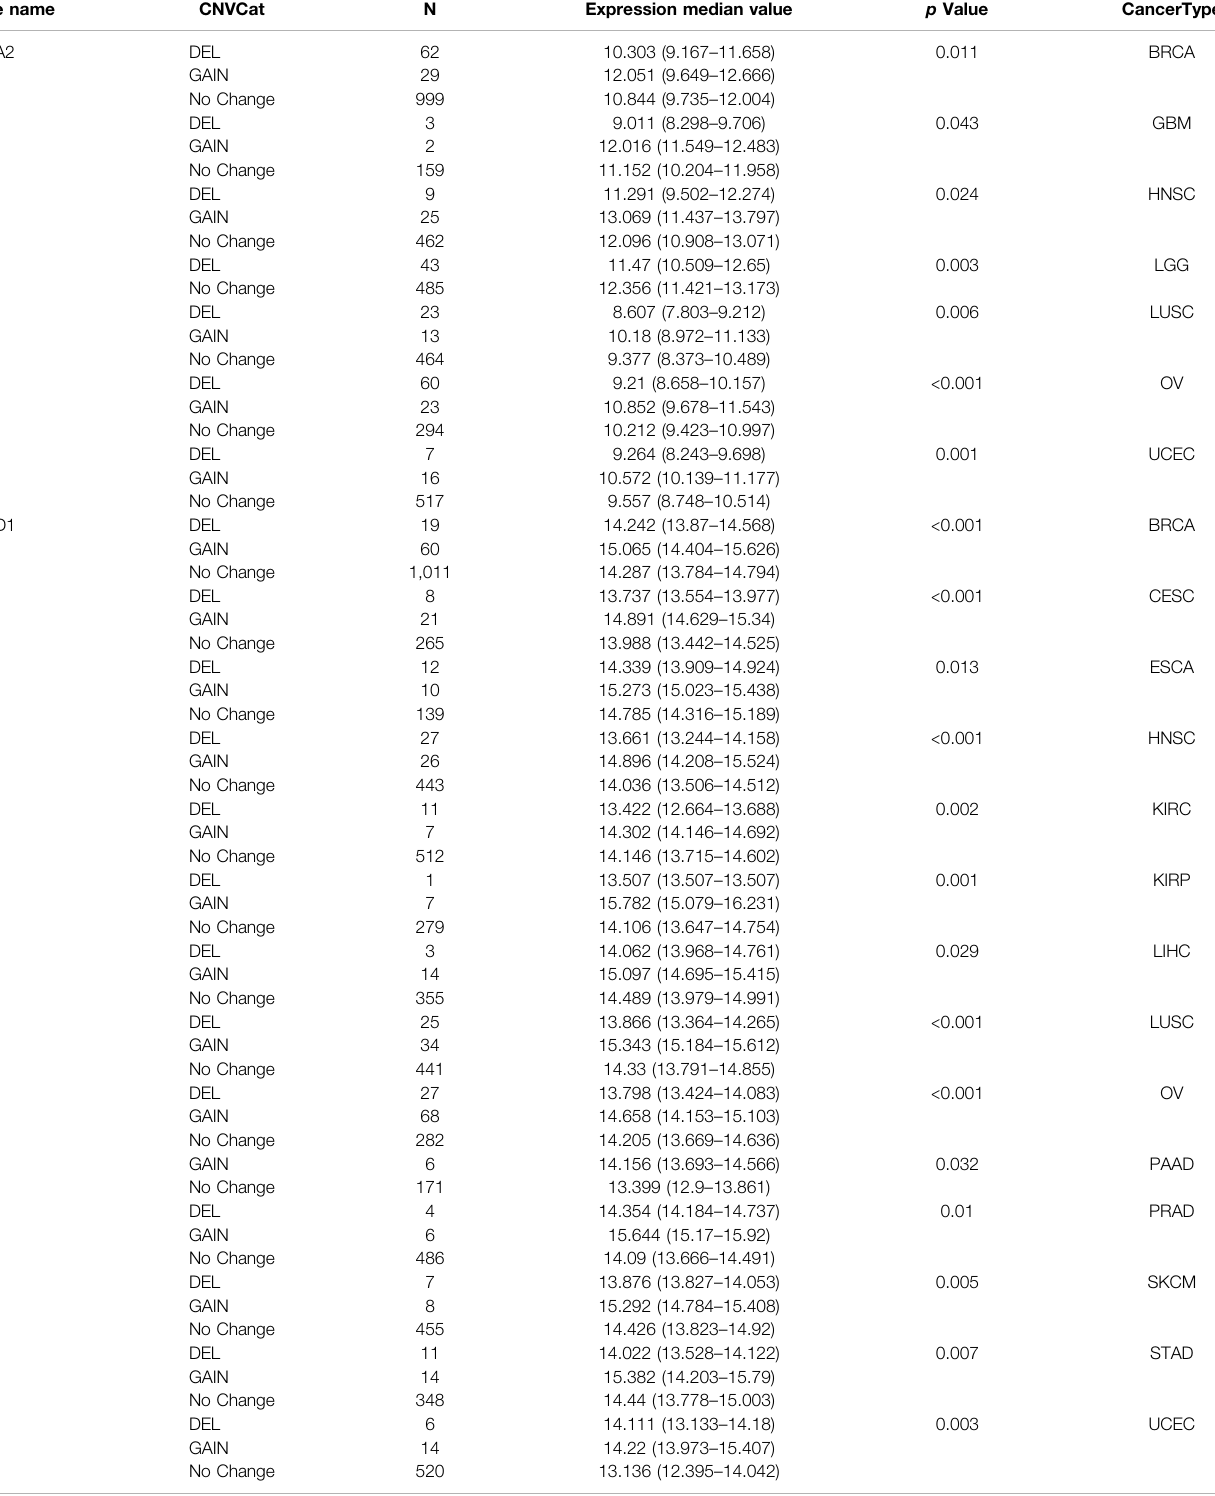
TABLE 5 | Relationships between heat shock protein expressions and copy number variations in